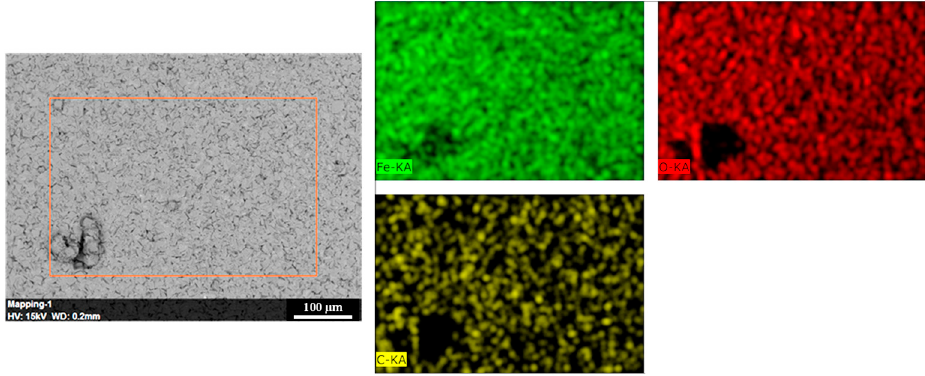
Figure 4. Product film morphology and EDS analysis of N80 Carbon Steel in high temperature and high pressure (100 °C-CO 2 : 0.63 MPa) corrosion environment.